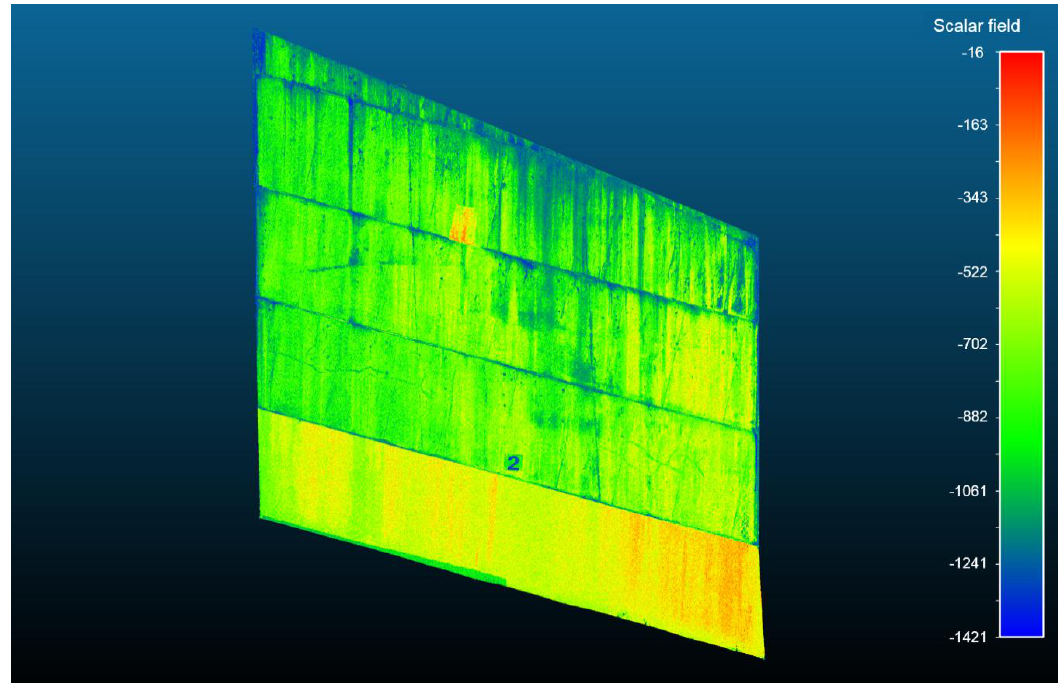
Figure 10. The scan image extracted from the TLS data.